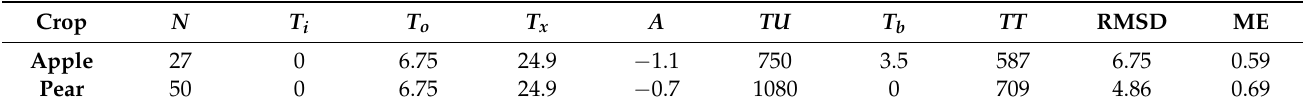
Table 2. Parameters of the model for the prediction of data for full flowering (F2) of trees of the ‘Gala’ apple and ‘Rocha’ pear 1 .